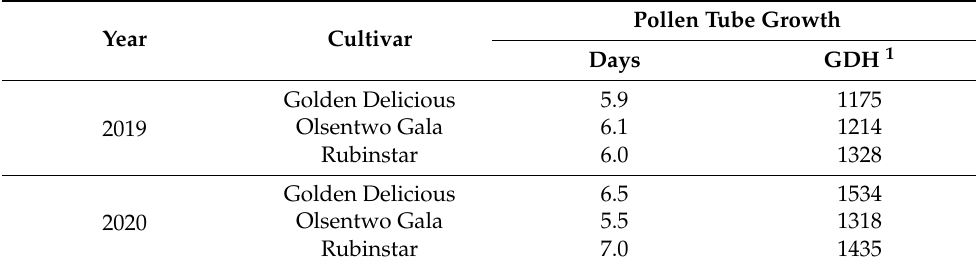
Table 2. Duration of pollen tubes to reach the ovules of ‘Golden Delicious’, ‘Olsentwo Gala’, and ‘Rubinstar’ flowers in 2019 and